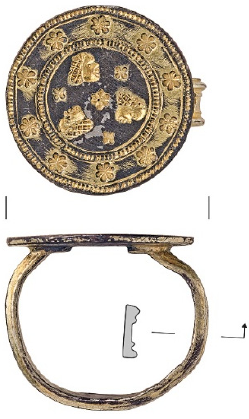
Figure 18. Treasure from Wiener Neustadt. Finger ring with “human heads” motif, 1 st half 14th century. Photo: Paul Kolp; editing: Franz Siegmeth.